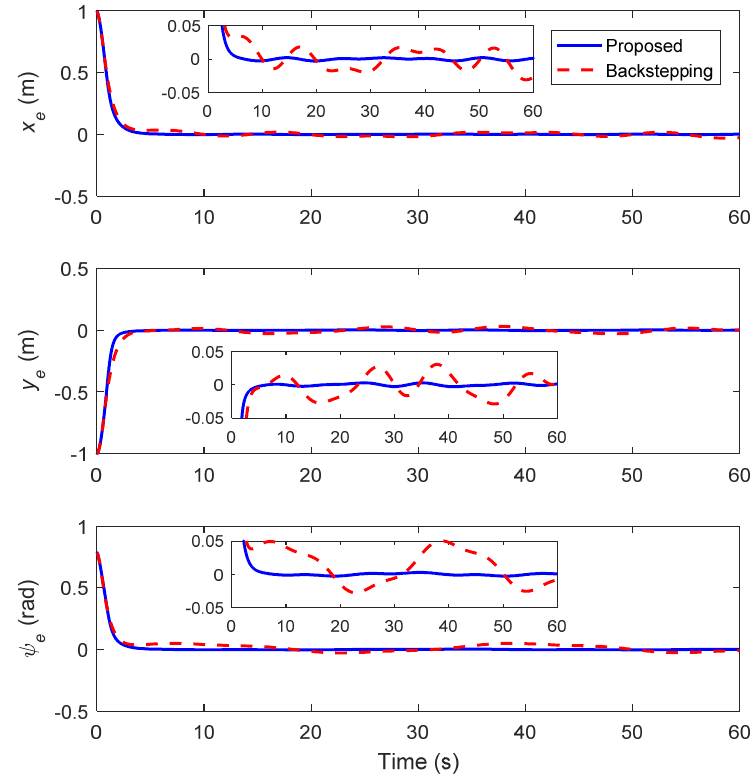
Figure 6. Pro fi le of the position tracking errors (Case 1).